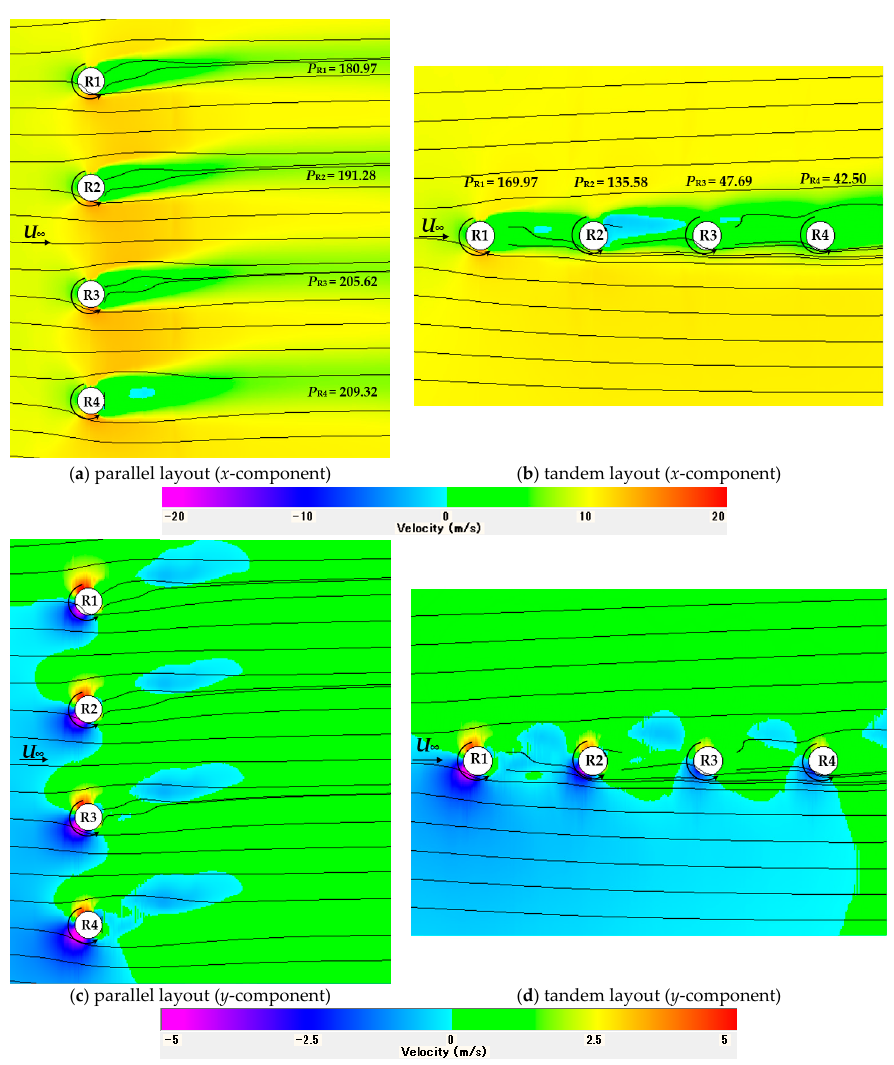
Figure 19. The upper figures show the prediction of the distributions of x -direction velocity compo- nents around four-rotor layouts: ( a ) parallel; ( b ) tandem. The lower figures show that of the y -direction velocity component: ( c ) parallel; ( d ) tandem. The upstream wind speed is 10 m/s and the inter-rotor space ( gap ) is 3.0 D